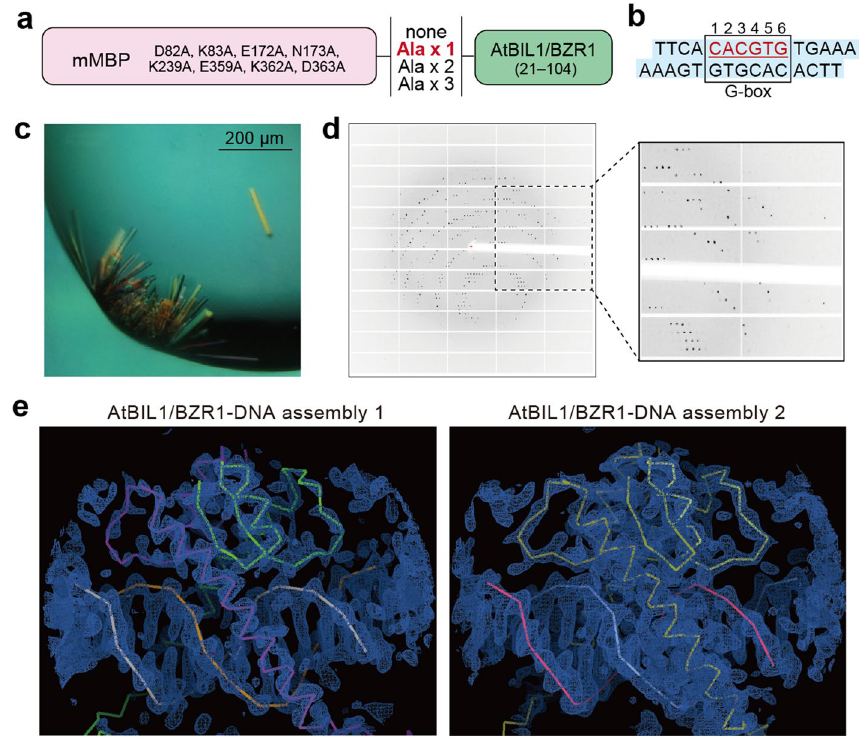
Figure 2. Crystallization and structure determination of MBP-fused AtBIL1/BZR1 in complex with DNA. ( a ) Mutant MBP (mMBP)-fused AtBIL1/BZR1 constructs for crystallization screening with different linker lengths. ( b ) DNA constructs successfully cocrystallized with mMBP-fused AtBIL1/BZR1 via one alanine linker. ( c , d ) Crystals ( c ) and an X-ray diffraction image (2.0 Å at the edge) from a crystal ( d ) of mMBP-fused AtBIL1/ BZR1 in complex with the G-box-containing DNA. ( e ) Electron density map (2 F o – F c ) of AtBIL1/BZR1-DNA assemblies with contours at 1.5 σ (blue meshes) in the asymmetric unit of the reported structure (PDB ID: 5ZD4) 12 depicted by the COOT program. The ribbons display the main-chain trace of two AtBIL1/BZR1 dimer- DNA complexes. Different colors represent different